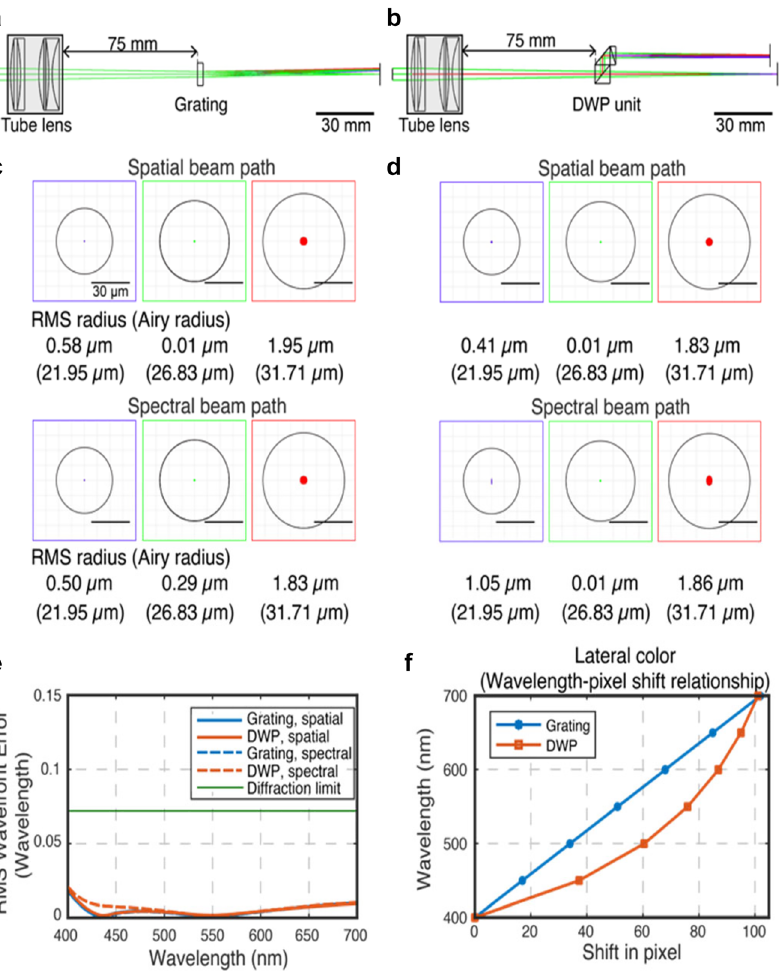
Figure 2: DWP performance evaluation using